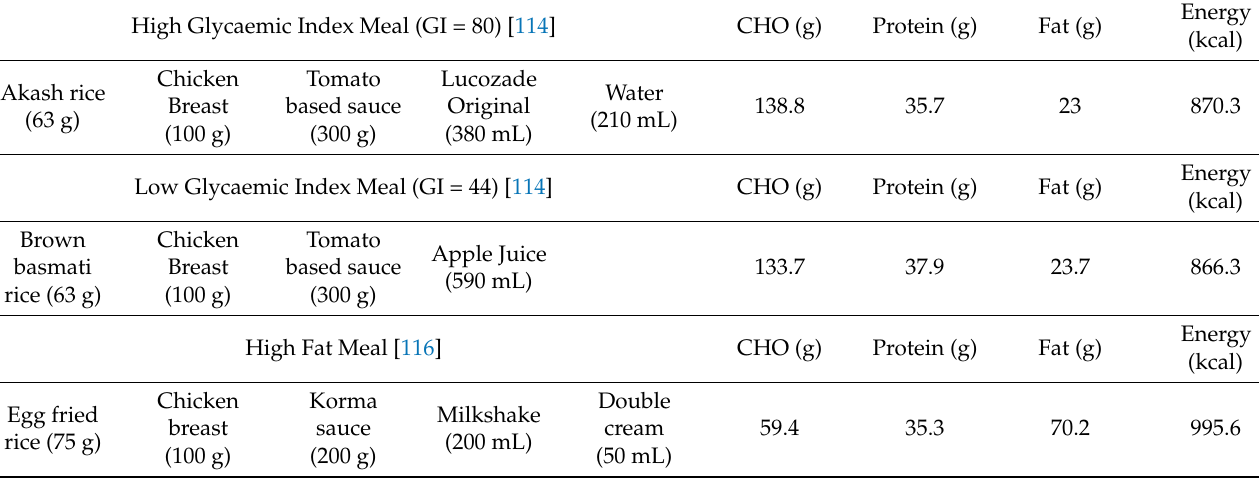
Table 3. Details of the ‘pre-match’ meals provided during investigations by Hulton et al.